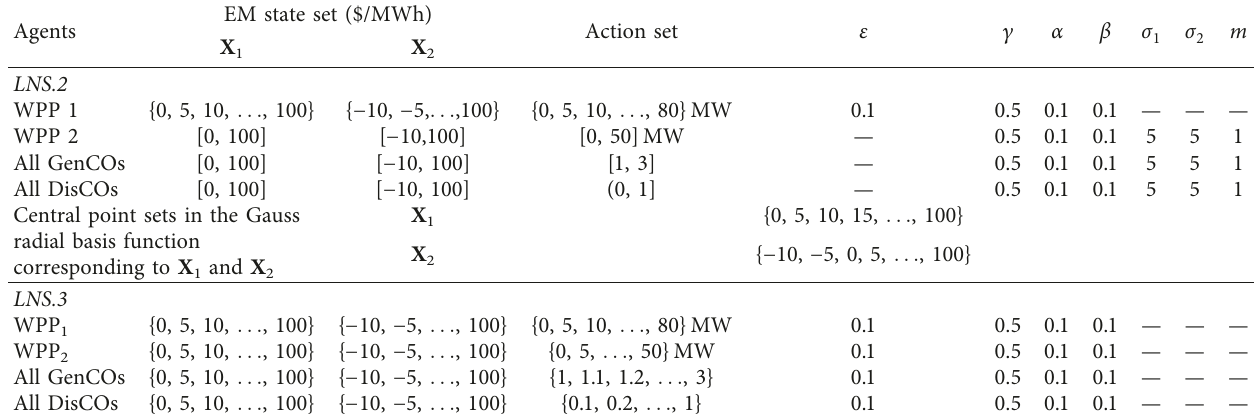
Table 6: Related information about LSN.2 and LSN.3.